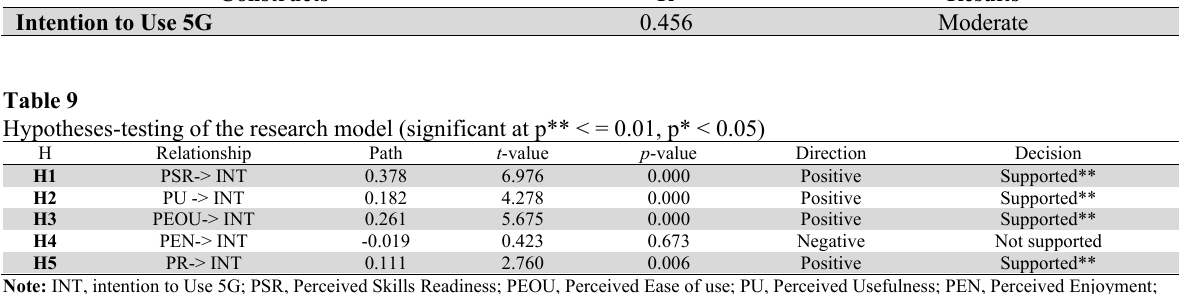
R 2 of the endogenous latent variables Constructs Results